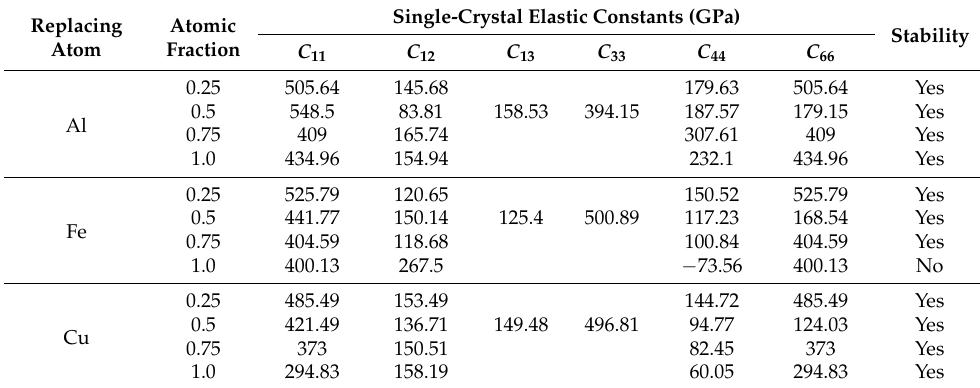
Table 14. It can be seen that the volume modulus, shear modulus, elastic modulus, and